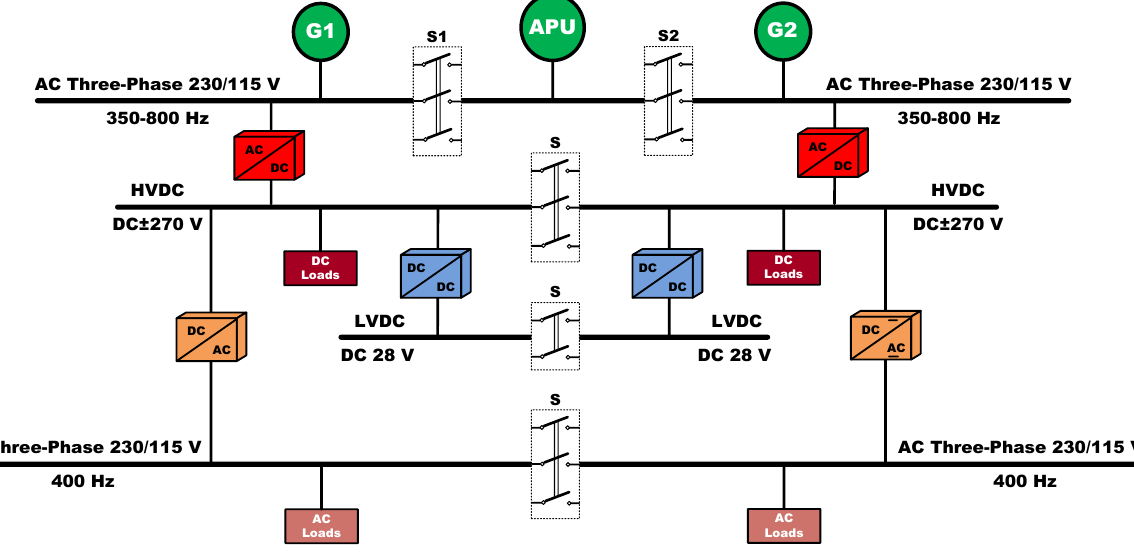
Figure 14. Electric scheme for a More Electric Aircraft.